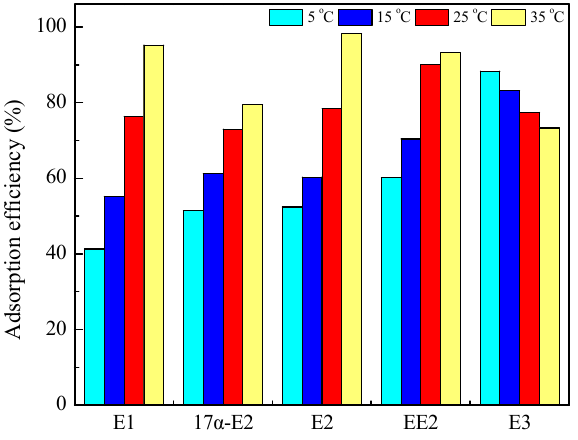
Figure 9. Effect of temperature on the MGO adsorption of estrogens (MGO = 0.05 g, pH = 5, t = 30 min, and estrogens’ concentrations = 200 μ g/L).